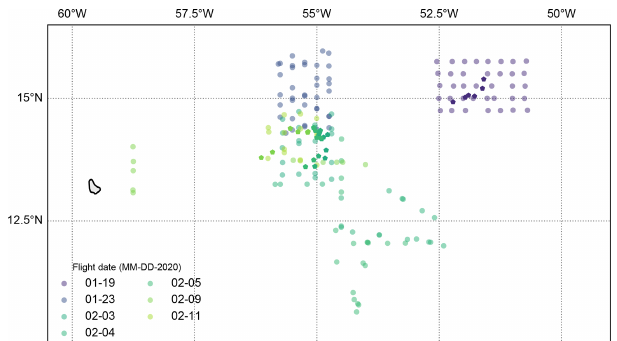
Figure 5. Location of AXBTs deployed during ATOMIC. Many were deployed in lawnmower patterns around the five drifting Sur- face Wave Instrument Float with Tracking (SWIFT) buoys de- scribed in Quinn et al. (2021); the positions of the buoys at the mid-point of the AXBT deployment is denoted with